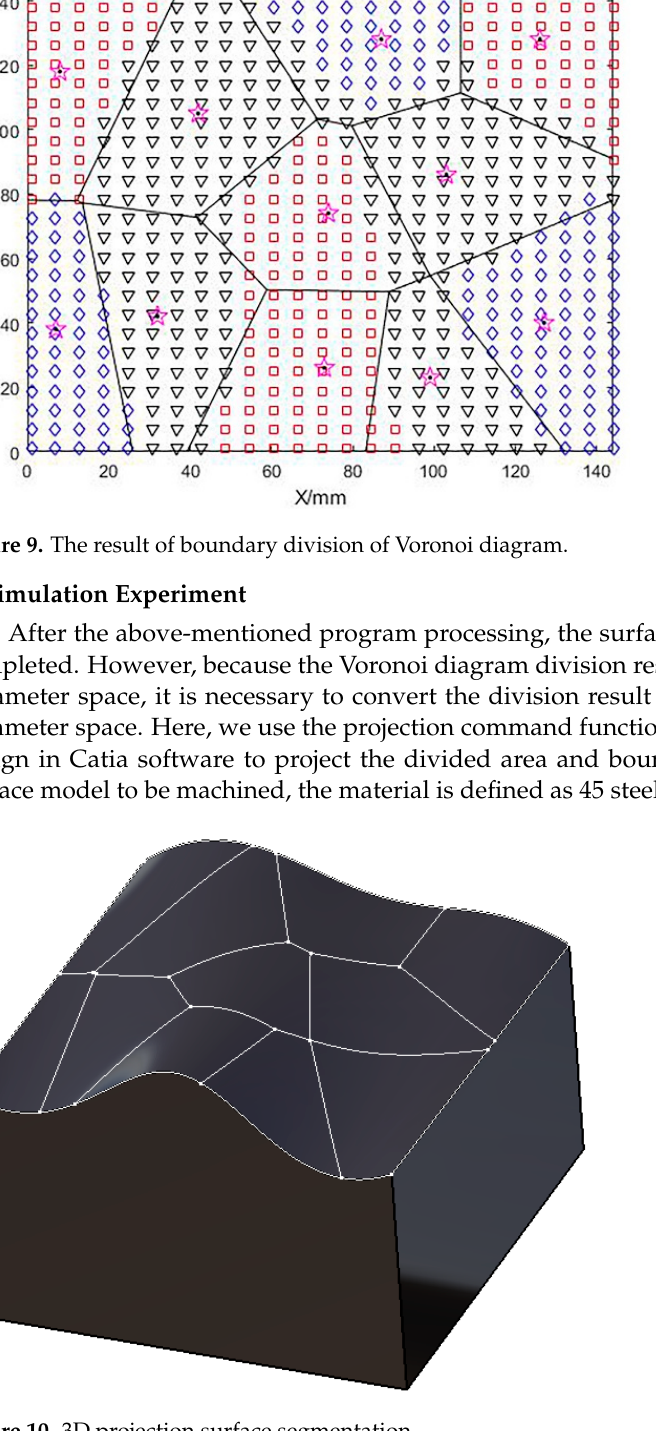
Figure 10. 3D projection surface